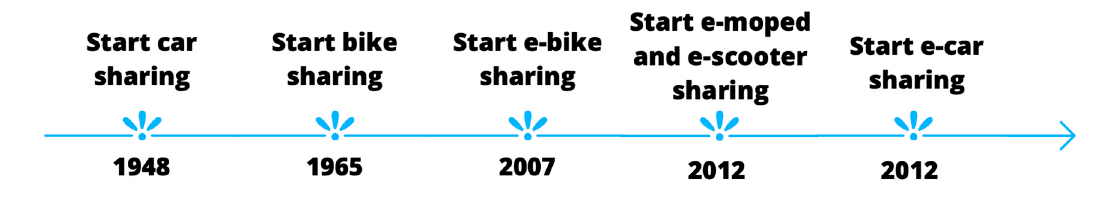
Figure 1. Shared mobility and electric ‐ shared mobility timeline.